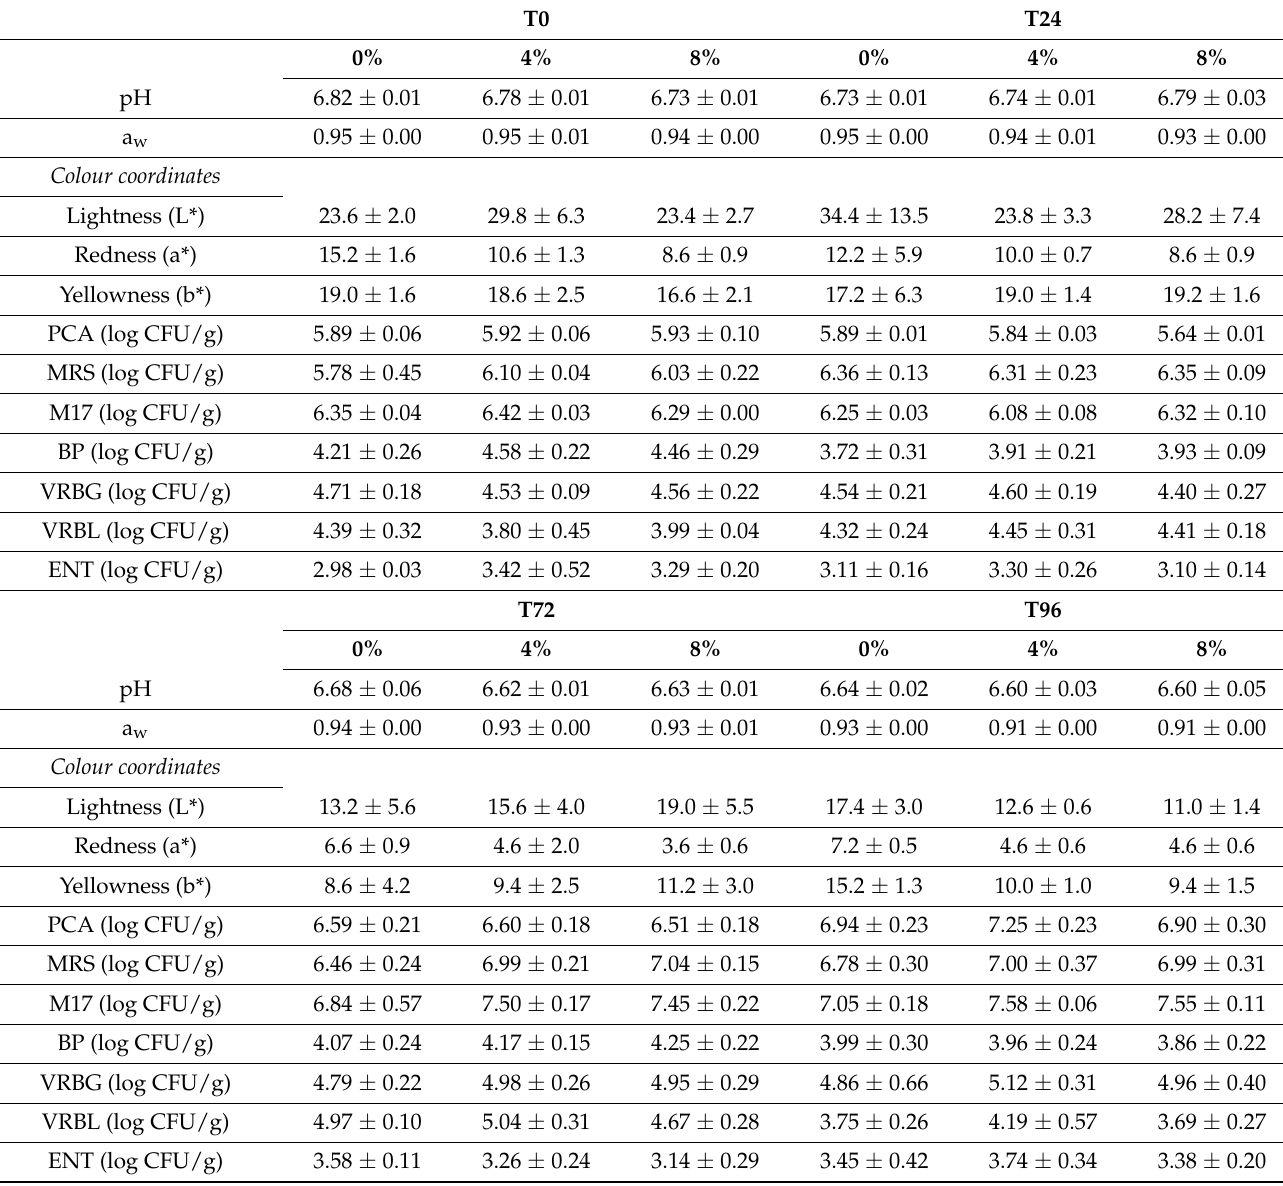
Table 5. Results of the physical-chemical, colorimetric and microbiological